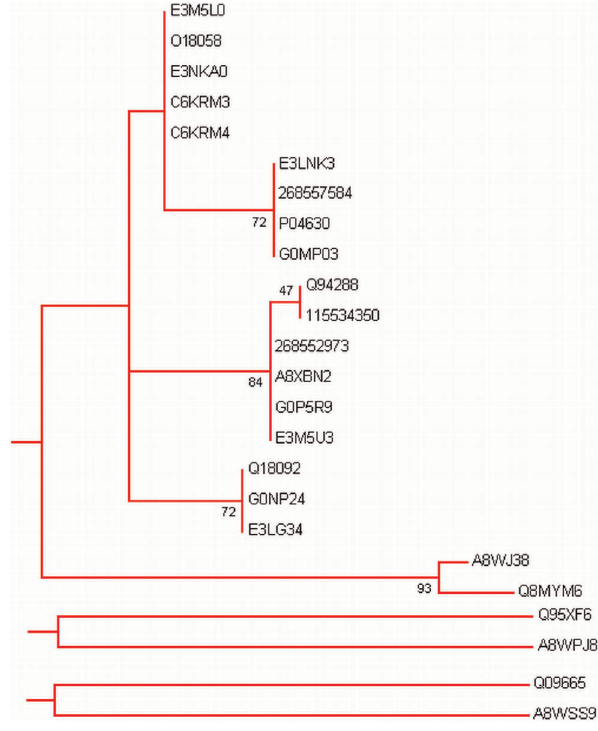
Figure 6. Group II. Tree showing all proteins included in this group.